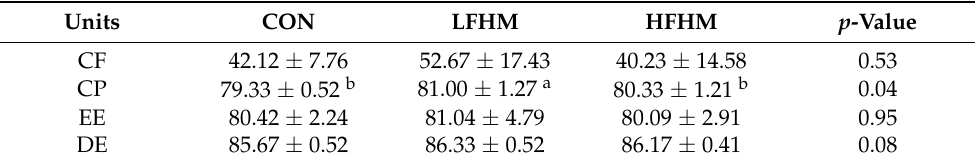
Table 3. Effects of different amounts of fermented Chinese herbal medicine on nutrient digestibility of weaned piglets (%).